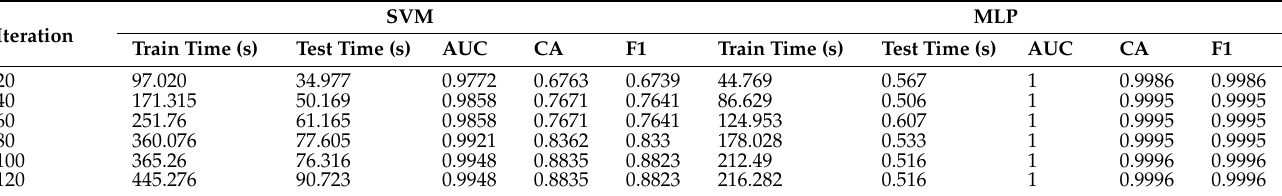
Table 4. Ablation study results on the MNIST dataset.